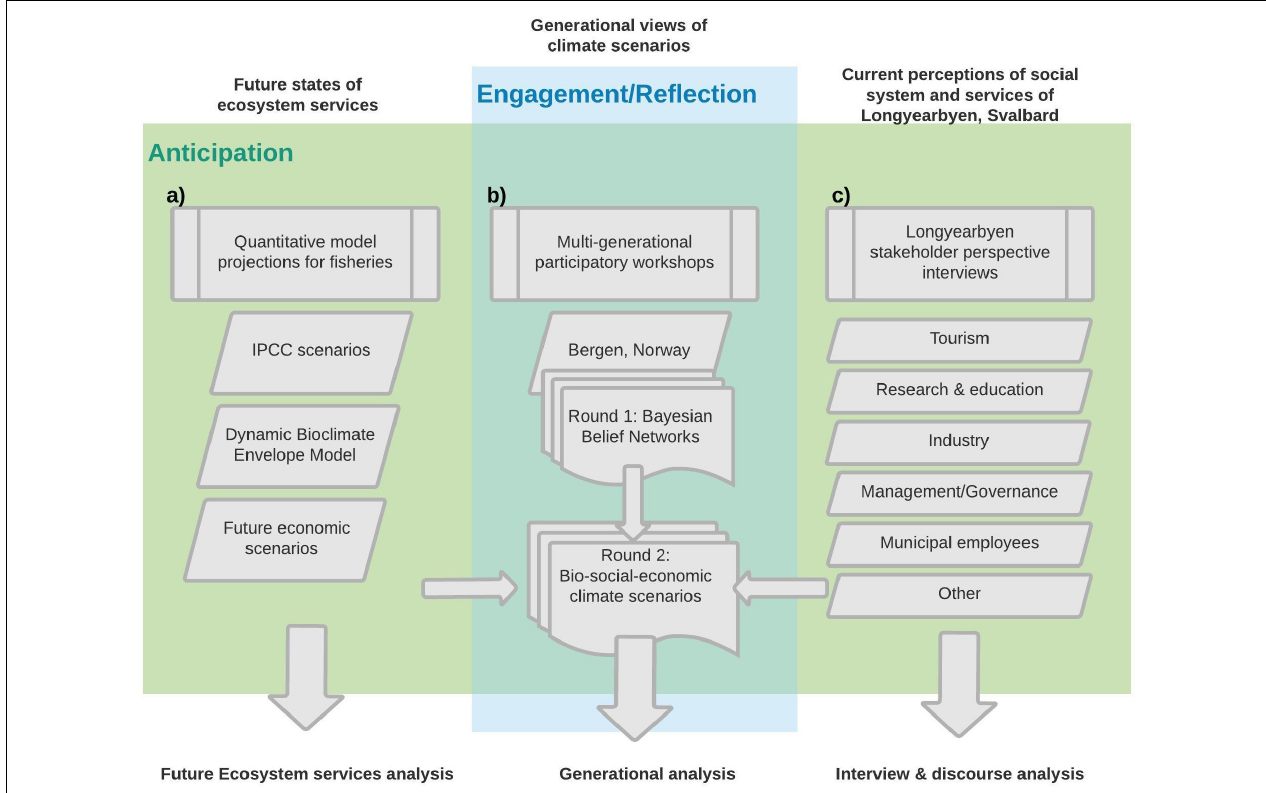
FIGURE 3 | A schematic of the interdisciplinary methodology developed for this paper. The three columns (a,b,c) represent the (a) modeling work, (b) workshops and (c) interviews. The arrows pointing to “Round 2” in (b) workshops show how the DBEM modeling and interviews were used to create the scenarios used in the second round of